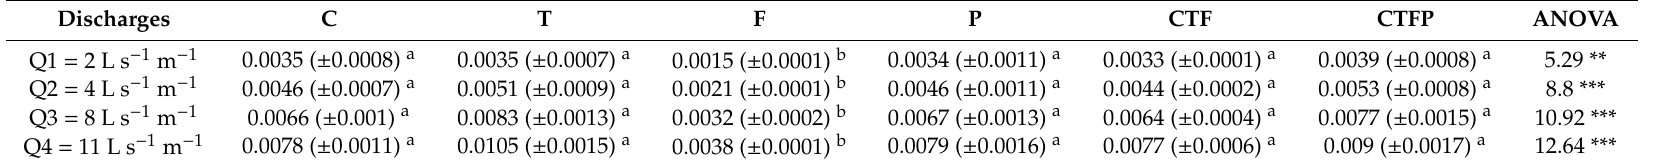
Table 1. Di ff erences in unit stream power for each community tested at each discharge.